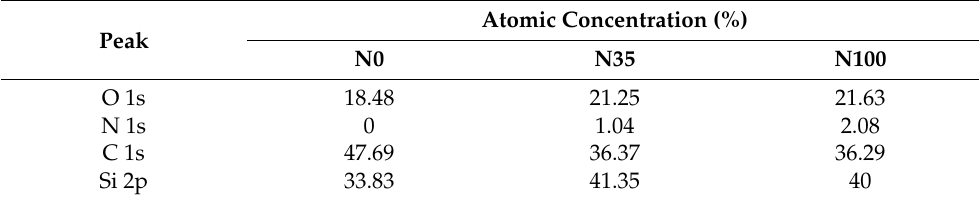
Figure 3. Deconvoluted high-resolution XPS spectra in N 1s region of pristine graphene ( a ), N35 ( b ), and N110 ( c ). Table 2. Atomic concentration calculation results.